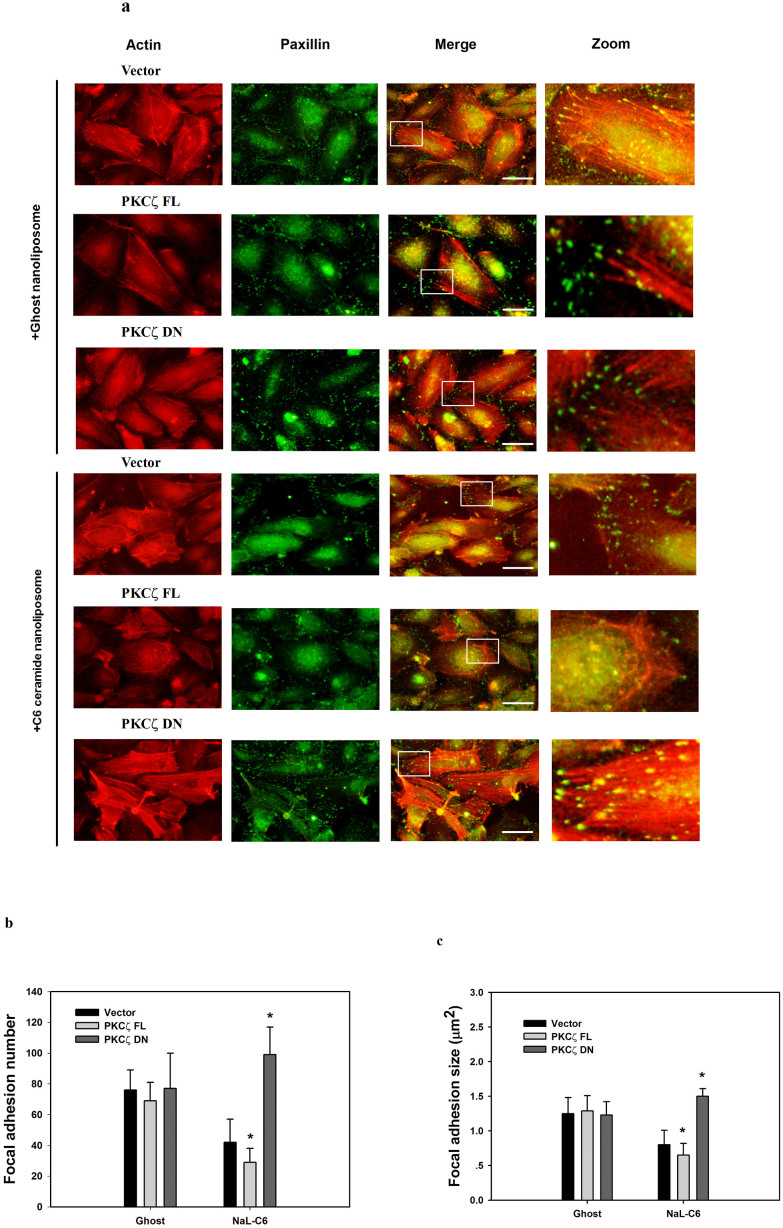
NaL-C6 reduced stress fiber formation and inhibited focal adhesion disassembly through PKCζ activation.(a) Vector, PKCζ FL or PKCζ DN-transfected MDA-MB-231 cells were treated with ghost or 20 μM NaL-C6 for 30 min. Cells were stained with rhodamine-phalloidin and paxillin antibody. The right panel shows magnified views of the boxed area in the merged images. Bar = 10 μm. (Geen = paxillin, red = F-actin). To verify the presence of PKCζ in given individual cells, the cells were further subject to anti-HA and anti-Alexa 350 staining. The cells shown in the images were all overexpressing target constructs. (b–c) Quantification of the average number and size (μm2) of paxillin-containing focal adhesions in vector, PKCζ FL or PKCζ DN-transfected cells treated with 20 μM C6-ceramide or ghost nanoliposomes for 30 min using ImageJ software. 12 cells were analyzed per condition in each experiment. Results were expressed as mean ± SEM. *p < 0.05 compared with vector control.